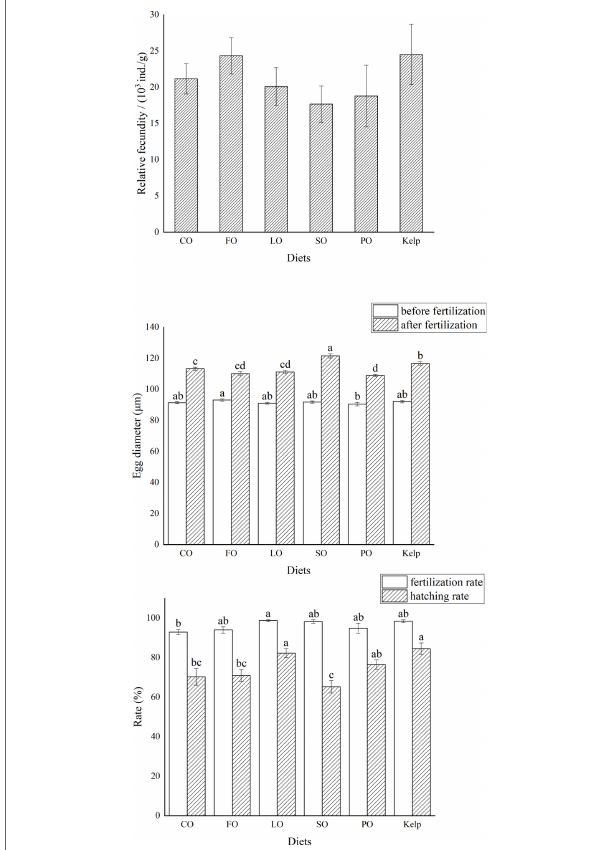
FIGURE 2 | Effects of different lipid sources (colza oil (CO), fish oil (FO), linseed oil (LO), soybean oil (SO), or palm oil (PO)) on the relative fecundity, egg diameter, as well as fertilization rate and hatching rate of sea urchin ( Strongylocentrotus intermedius ) (mean ± SEM, n=3). Mean value bars within the same parameter of each chart bearing with different lowercase letters are significantly different at P <